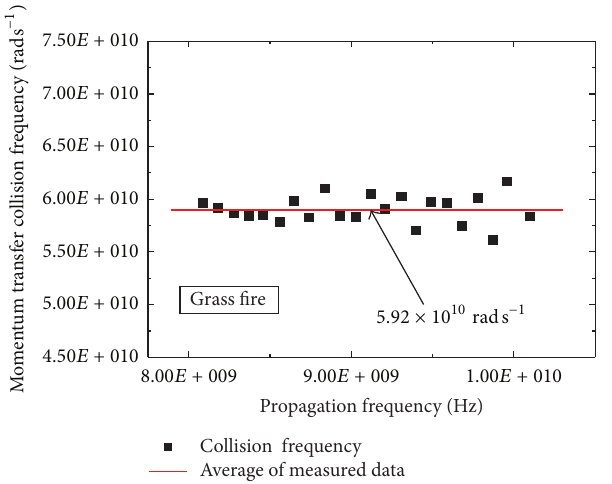
Figure 6: Eucalyptus litter fire absorption maxima and collision